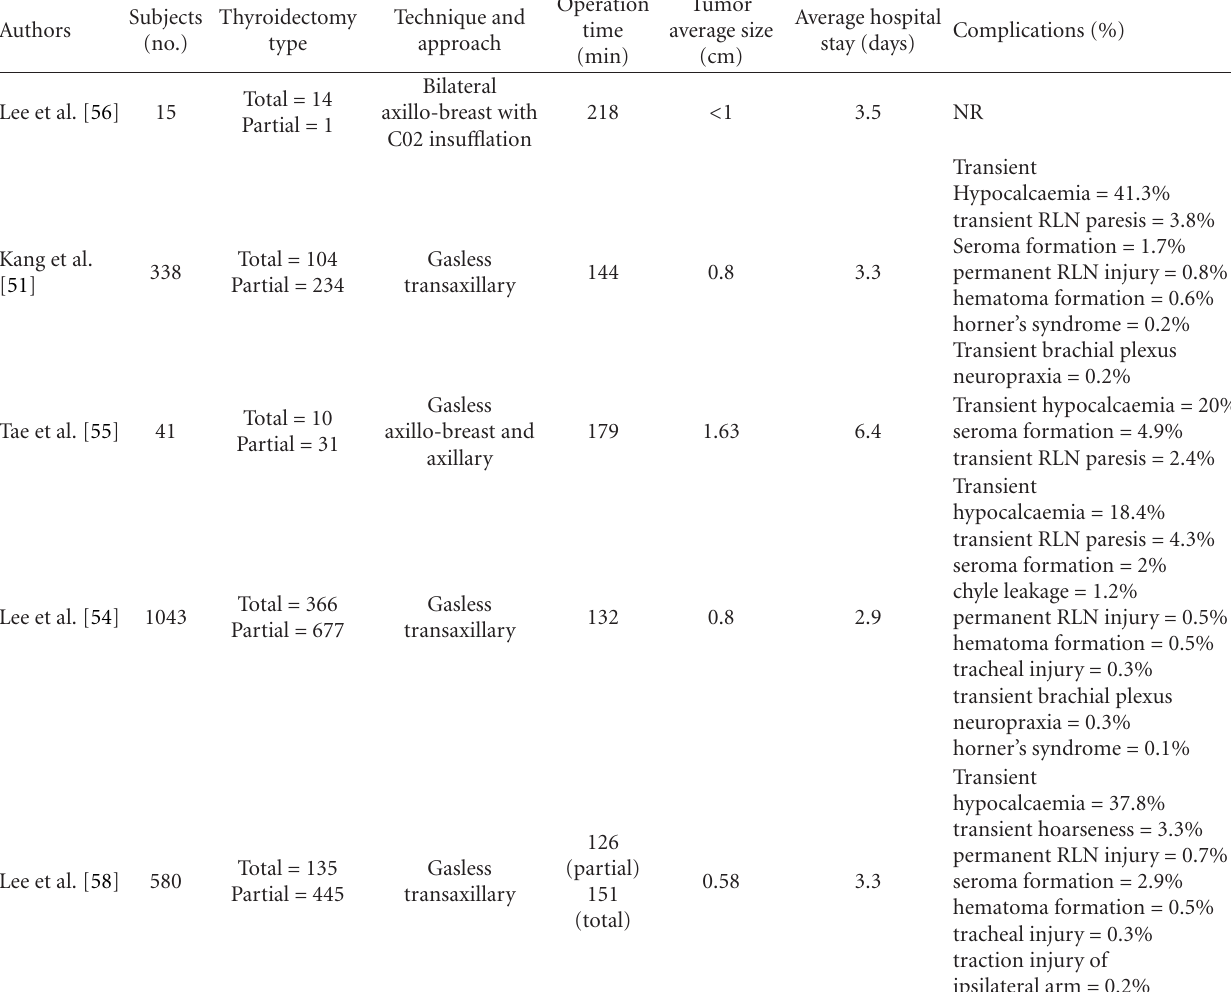
Table 2: Major clinical series in robot-assisted